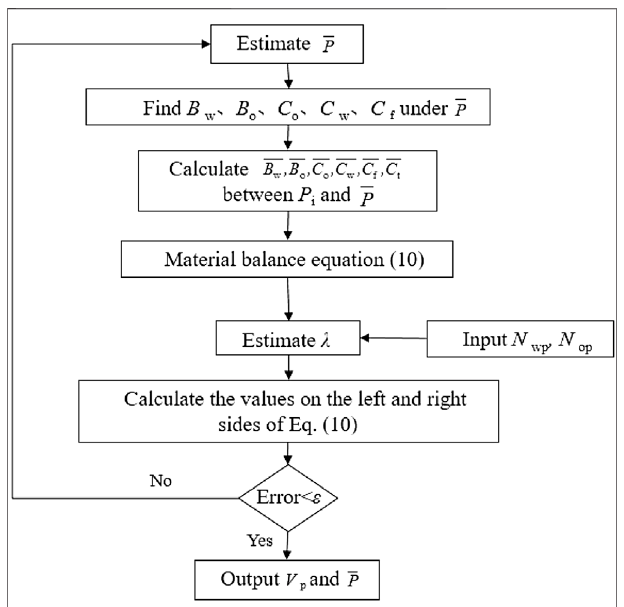
FIGURE 1 | Dynamic drainage volume calculation fl ow chart.